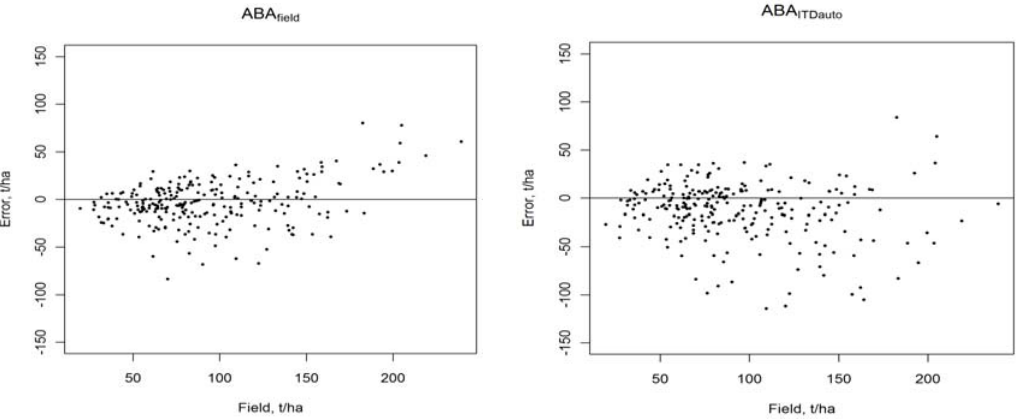
Figure 5. Residual plots for AGB (t/ha) with the